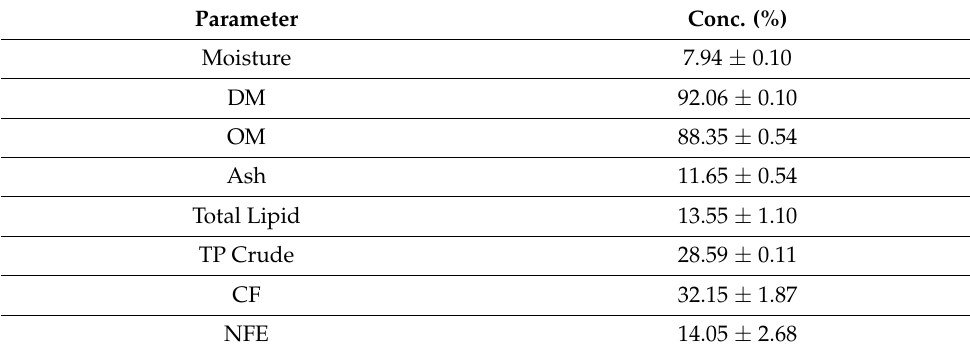
Table 1. Chemical composition of Moringa leaves.